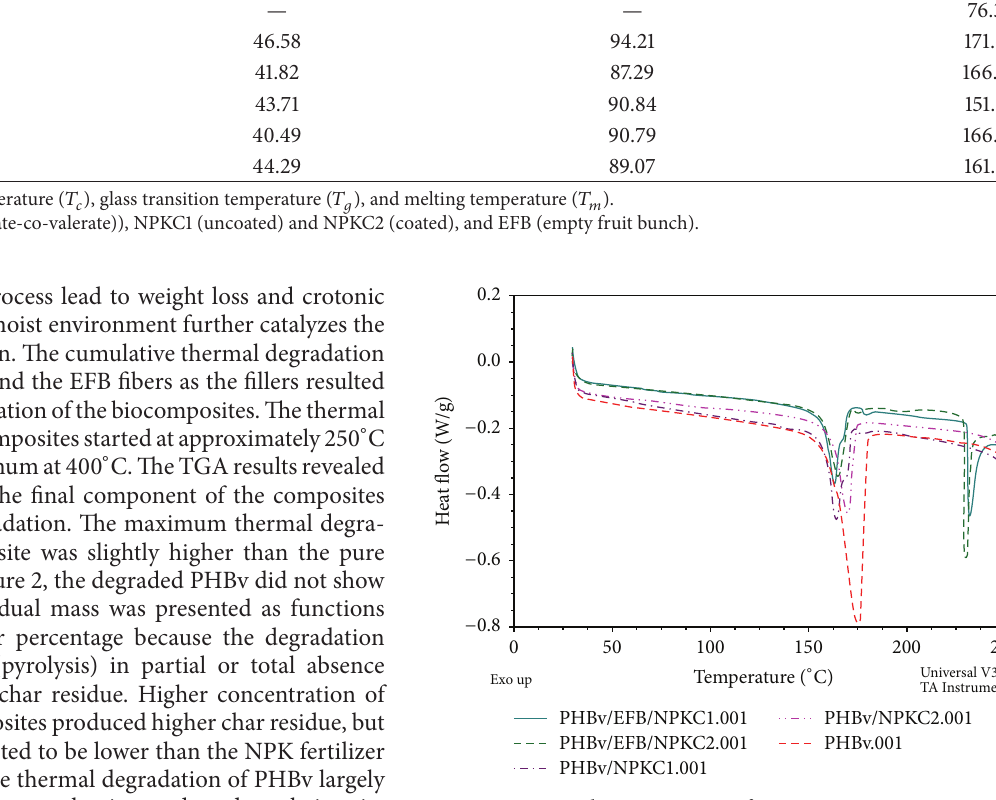
Figure 3: DSC characterisation of pure PHBv, PHBv/NPK, and PHBv/NPK/EFB composites. Note: PHBv (poly(hydroxybutyrate- co-valerate)), NPKC1 (uncoated) and NPKC2 (coated), and EFB (empty fruit